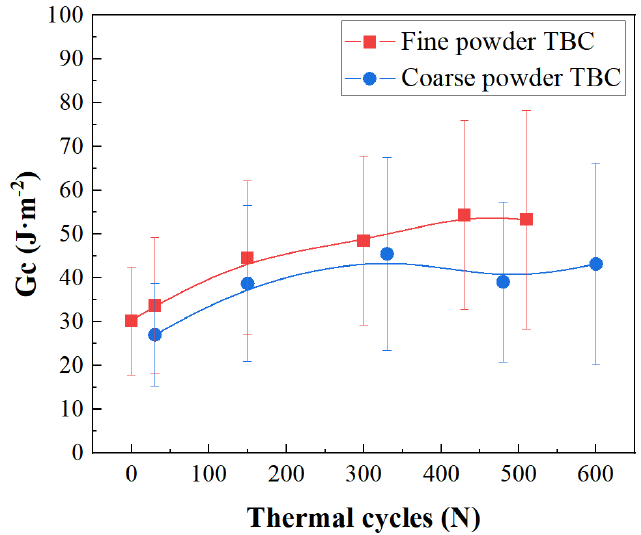
Figure 6. Evolution of fracture toughness of two kinds of coatings during thermal cycling test.